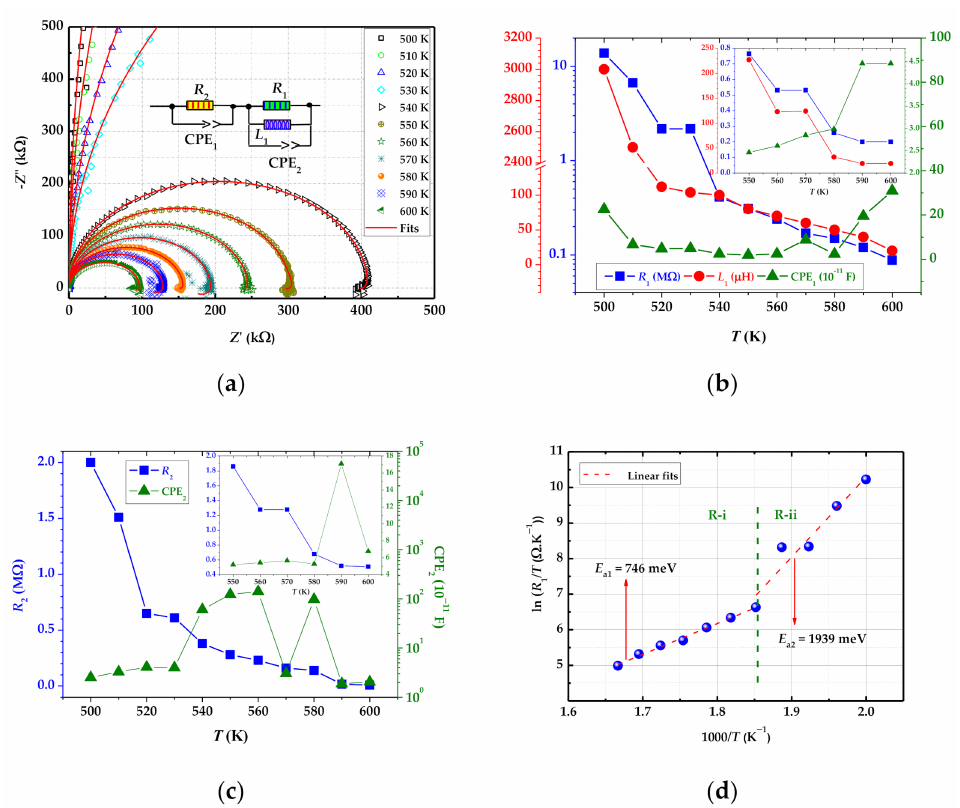
Figure 6. ( a ) Nyquist diagrams ( Z ” vs. Z ’) of In 2 S 3 :Ag film at various temperatures; ( b ) Resistance, inductance, and capacitance of elements of component 1 of the equivalent circuit as function of the temperature. The inserted graphs correspond to the undoped sample; ( c ) resistance and capacitance of elements of component 2 of the equivalent circuit as function of the temperature. The inserted graphs correspond to the undoped sample; ( d ) variation of ln the